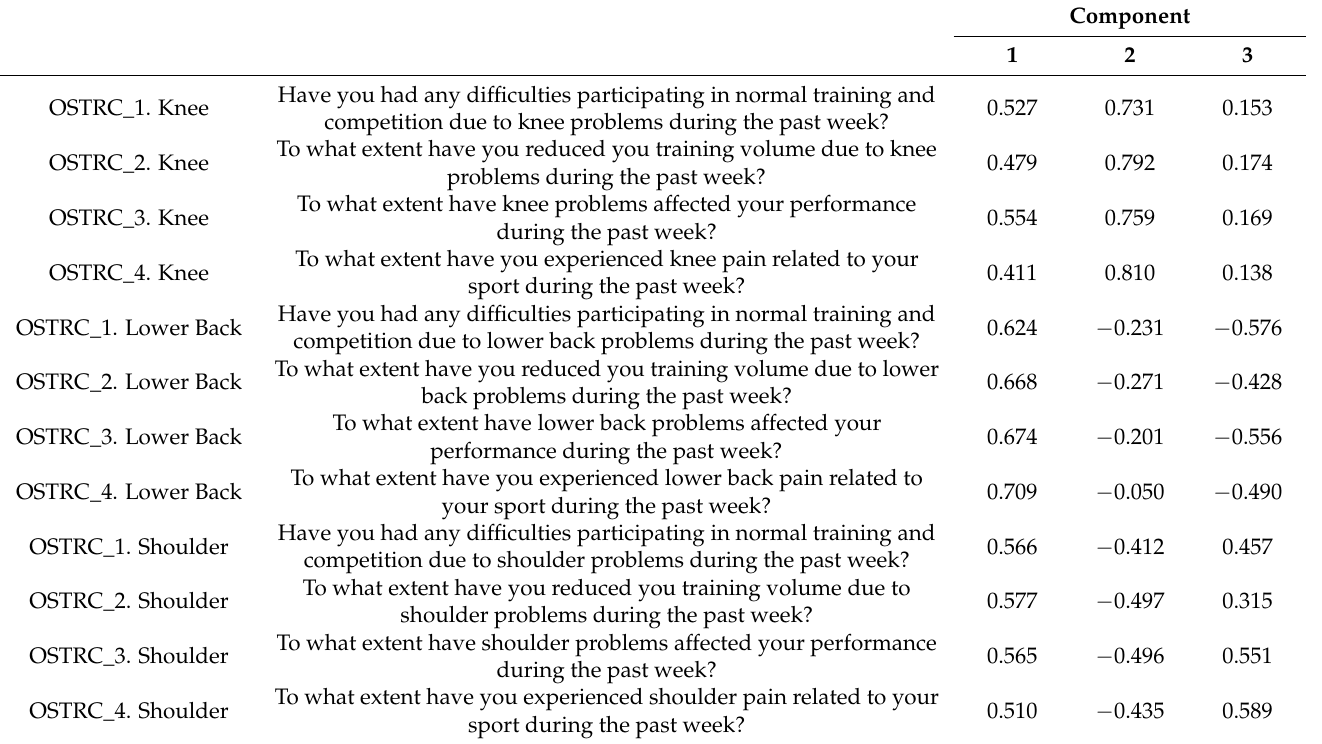
Table 4. Matrix of the OSTRC-Sp components, where you can see their distribution between each of the factors of the OSTRC-Sp.